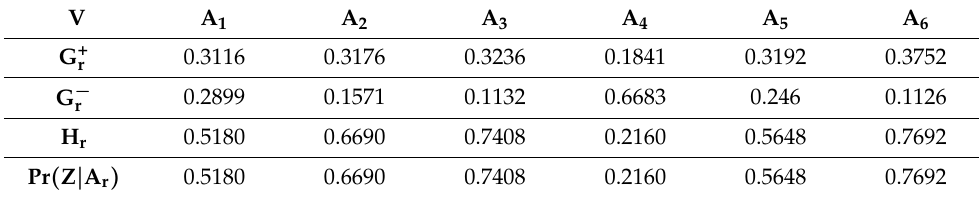
Table 8. The GRC, RRD and conditional probability.